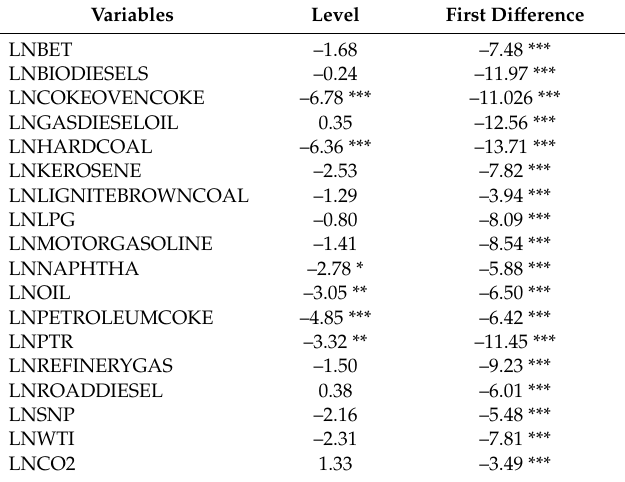
Table 5. The outcomes of the augmented Dickey-Fuller test.